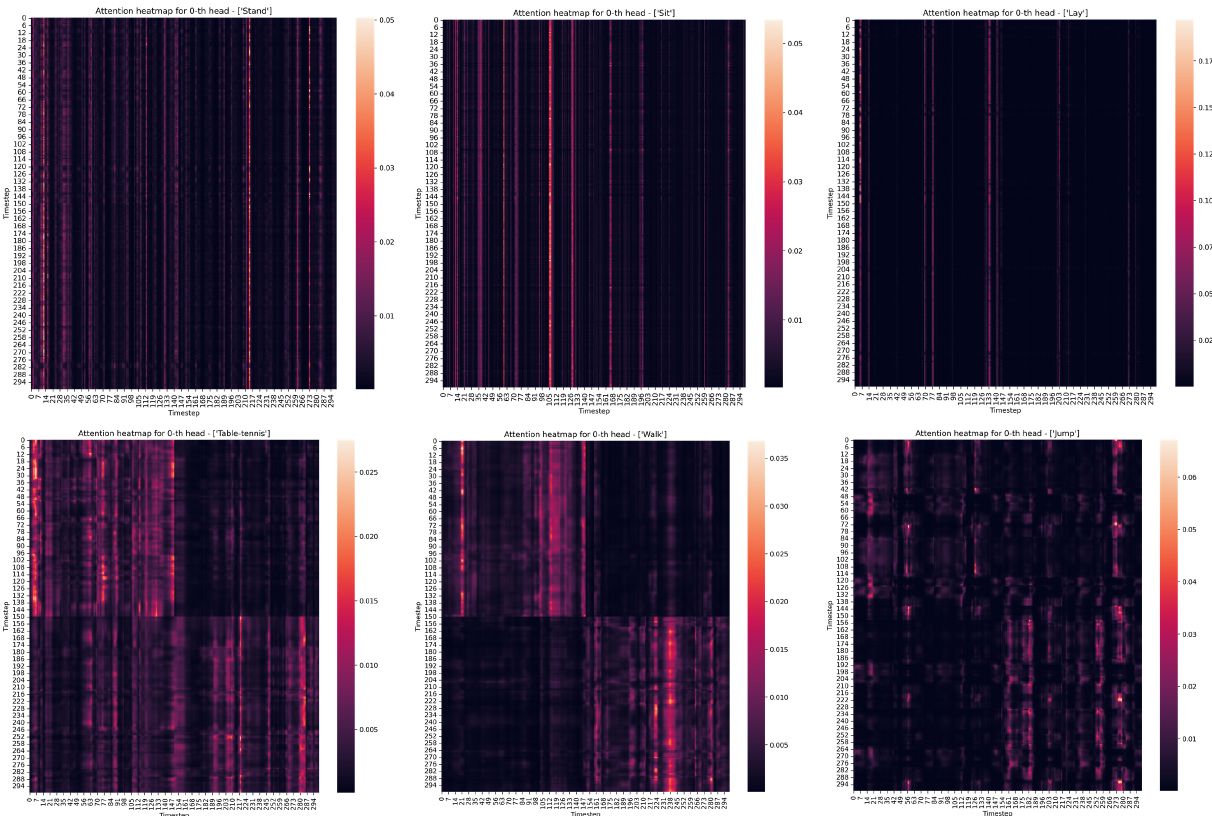
Figure 5. Attention heatmaps of different single